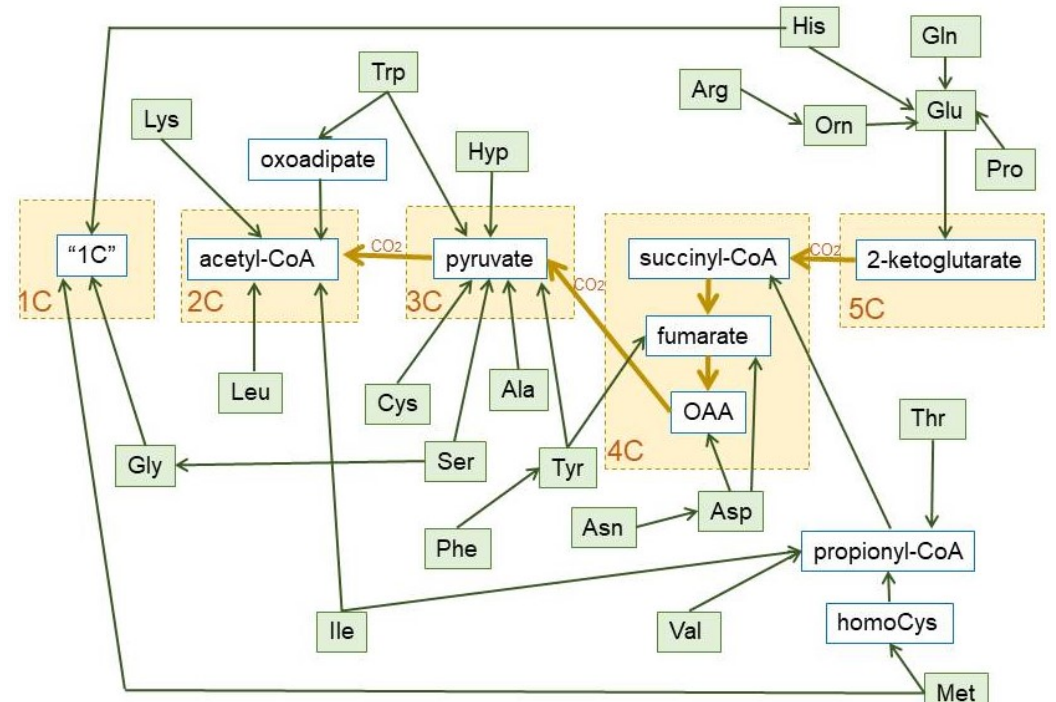
Figure 6. Summary of the final conversion of dietary protein amino acids in 1C, 2C, 3C, 4C, and 5C fragments, which revert essentially into 3C and 2C, during the human catabolism of amino acid hydrocarbon-skeletons. The pathways used to prepare this graph are the most common, including the main alternate pathways [105]. The green lines show the carbon paths for each amino acid, the brown lines represent the relationship between the core of the TCA cycle and pyruvate dehydrogenase (with the loss of one CO 2 between each substrate group box (marked in yellow). Non-standard abbreviations: Hyp = L-4-hydroxyproline; Orn = ornithine; “1C” = One-carbon fragment donor systems.